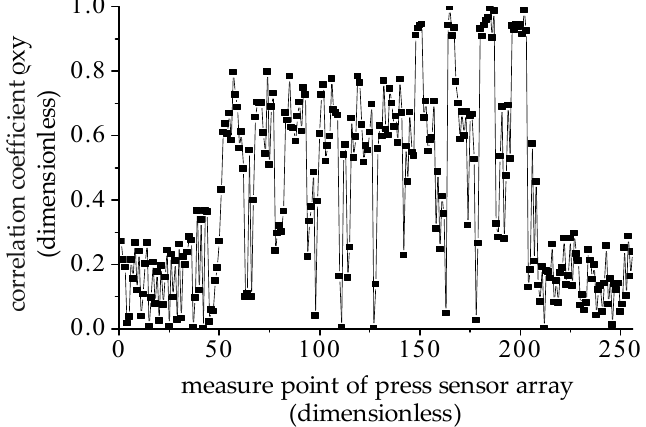
Figure 13. Correlation coefficient analysis of heartbeat signals and electrocardio-signals.